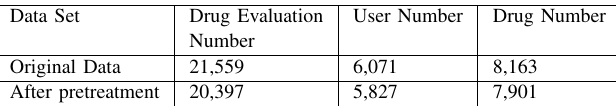
Fig. 4. After tensor decomposition